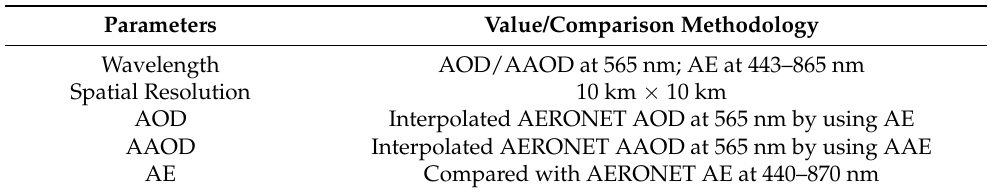
Table 2. The detailed information and comparison methodology of POLDER-3/GRASP aerosol products used in this